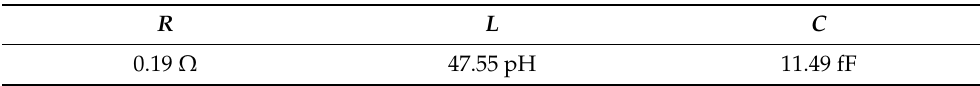
Table 3. Extracted RLC lumped elements values from GaInAsSb/InP UTC-PD Open and Short test structures.